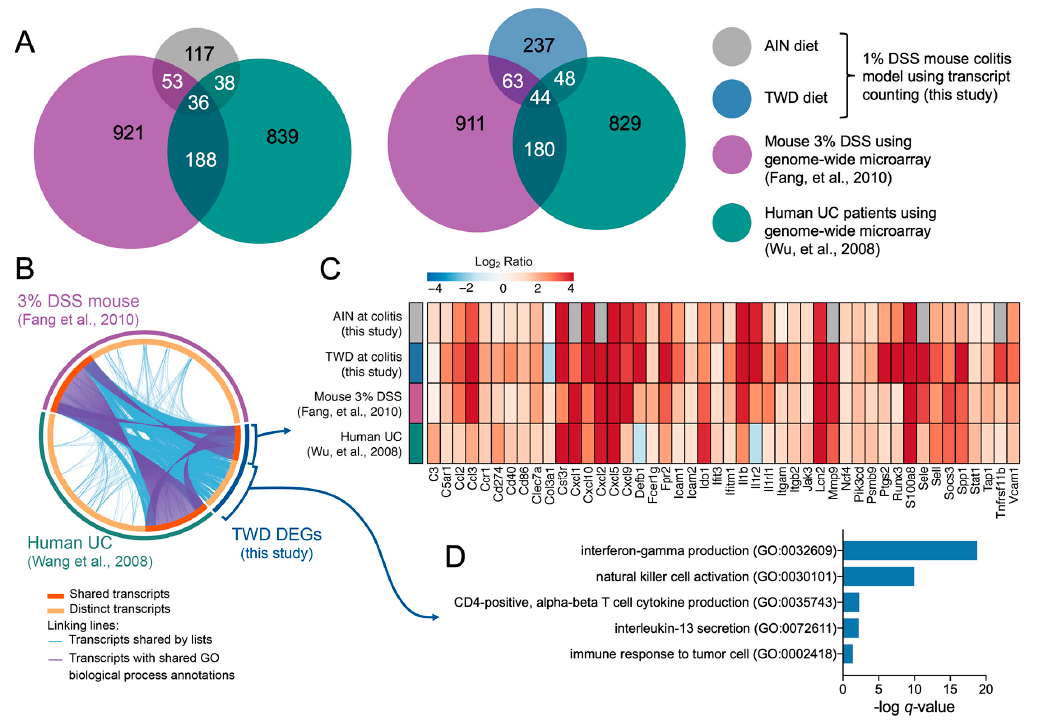
Figure 12. Identification of common colitis-responsive transcripts in dextran sodium sulfate (DSS) models of colitis and human ulcerative colitis (UC) patients. Expression data from this study were compared to prior reports using genome-wide microarray platforms as noted in the Materials and Methods. ( A ) Venn diagrams depicting overlap in differentially expressed genes (DEGs) are shown comparing colitis-responsive transcripts in mice fed the AIN93G (AIN) diet or total Western diet (TWD) to DEGs identified using a 3% DSS model of colitis in C57BL/6J mice (purple) [68] or DEGs identified in colon mucosa of human UC patients [70]. ( B ) Circos plot showing overlap of DEGs (purples lines) and overlap of shared ontology terms (blue lines) for TWD DEGs at colitis compared to DEGs for the 3% DSS mouse model or DEGs identified in human UC patients. ( C ) Heat map depicting the log 2 fold change values for those DEGs identified as common to each transcriptional profile. Note that the AIN and TWD DEG lists were merged to generate the heatmap, resulting in a total of 46 genes. Gray boxes within the AIN data set indicate genes that did not meet the detection threshold for nSolver data analysis. ( D ) Gene ontology biological process terms significantly enriched ( p < 0.05, enrichment minimum 2) in list of 237 DEGs unique to TWD at colitis (this study) as determined using the complete probe set as the background gene list (Metascape).